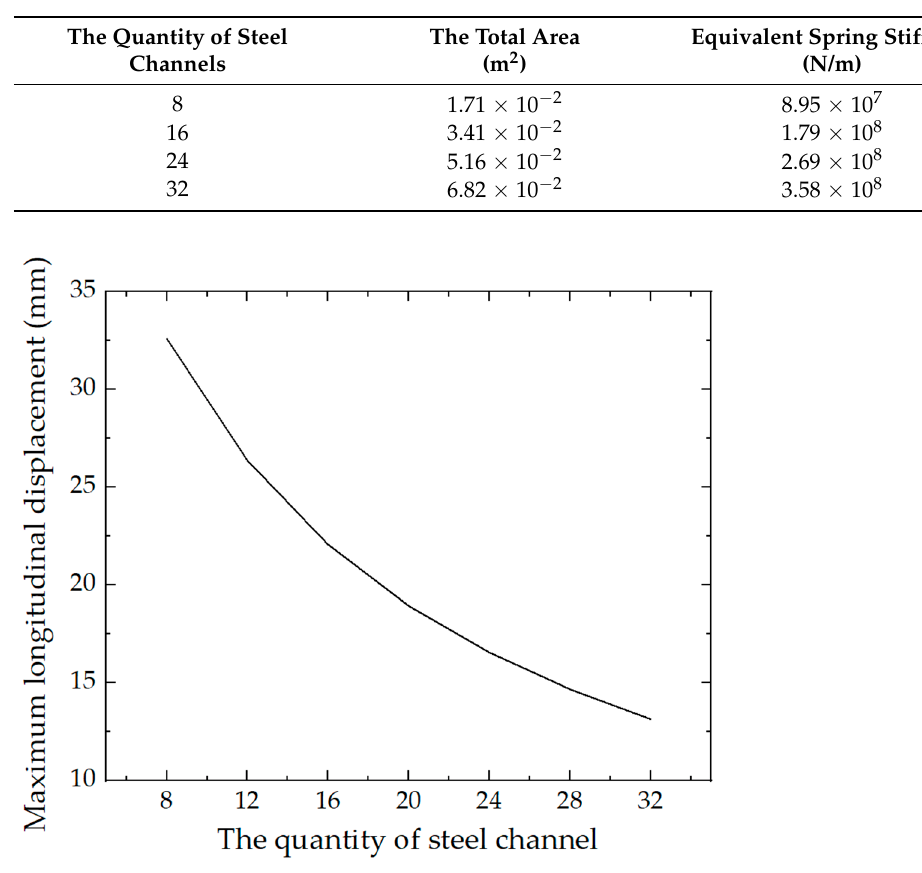
Table 4. Equivalent spring stiffness of steel channels under different quantities.